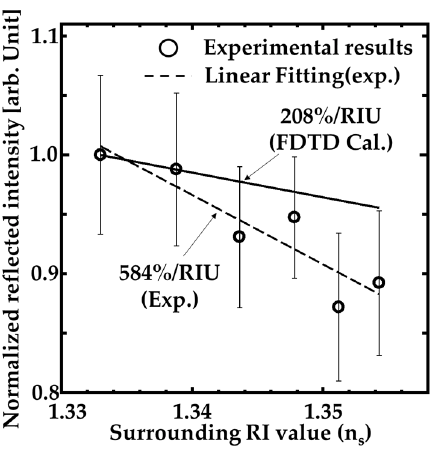
Figure 10. Dependence of the peak intensity of GaN-HCG on n s (FDTD calculation).